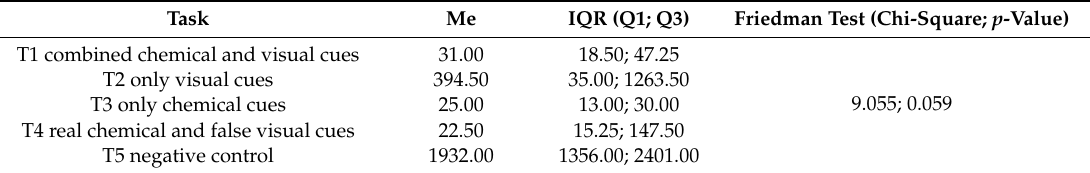
Table 8. Time spent ( ∆ t) by Octopus vulgaris in problem-solving (second).